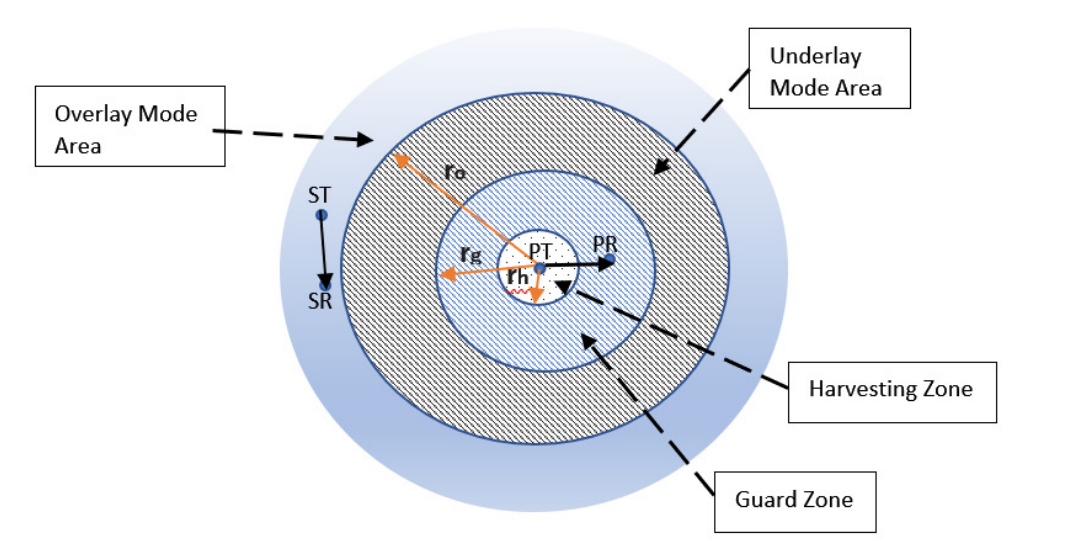
Figure 1. Allocation of coverage area into different zones. ST = secondary transmitter; SR = secondary receiver; PR = primary receiver; PT = primary